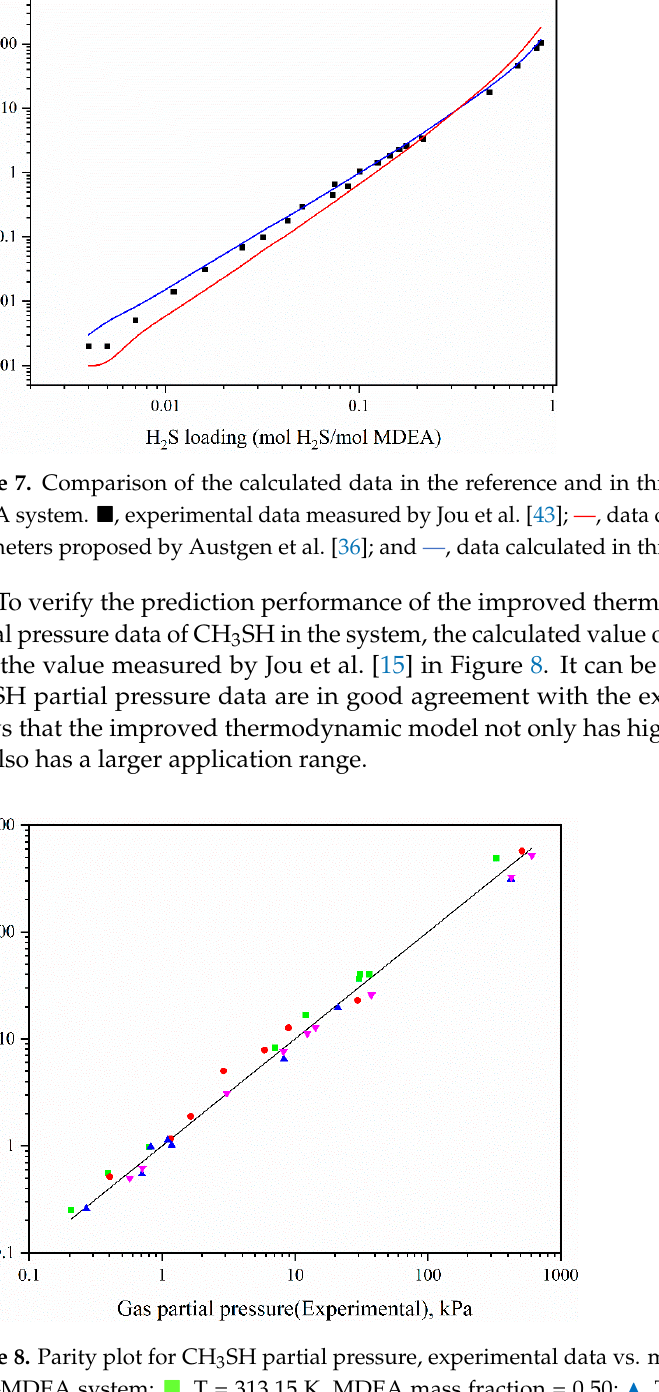
CH 3 SH–H 2 O–MDEA system: ■ , T = 313.15 K, MDEA mass fraction = 0.50; ▲ , T = 343.15 K, MDEA mass fraction = 0.50. CO 2 –H 2 S–CH 3 SH–H 2 O–MDEA system: ● , T = 313.15 K, MDEA mass fraction = 0.50;